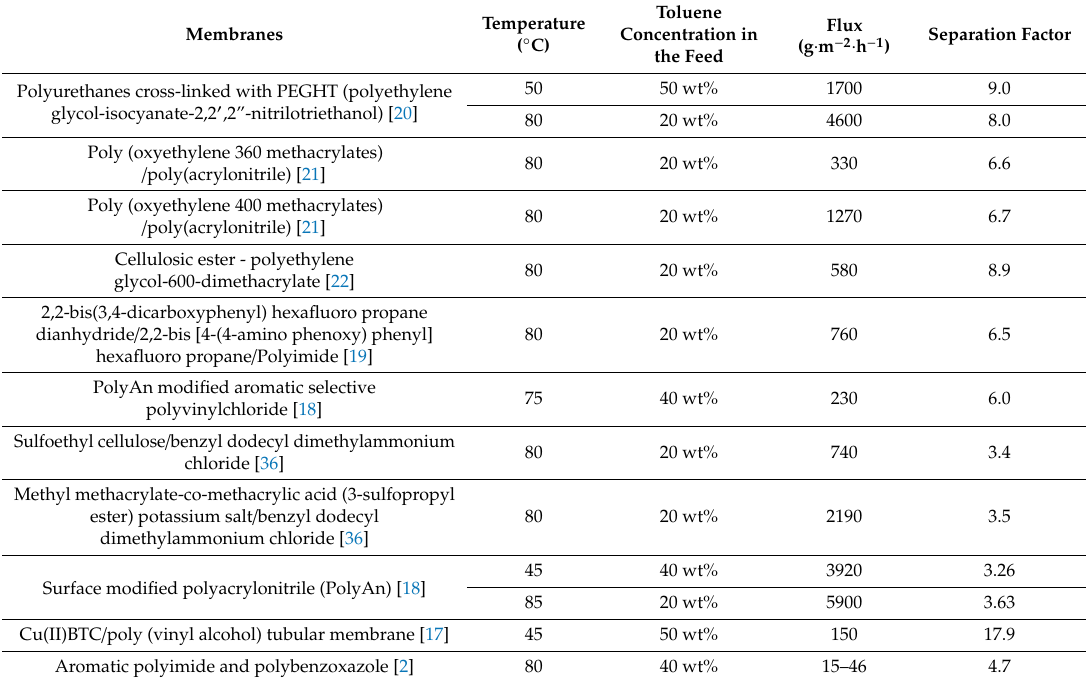
Figure 8. ( A ) Variation of degree of swelling as a function of crosslinking agent concentration for membranes incorporating 7 wt% Cu(II)BTC; ( B ) variation of degree of swelling as the percentage of MOFs incorporated in the membrane which was treated with 50 g/L of the crosslinking agent. Table 2. Comparison of the present study with previously published studies for separation of toluene / n-heptane